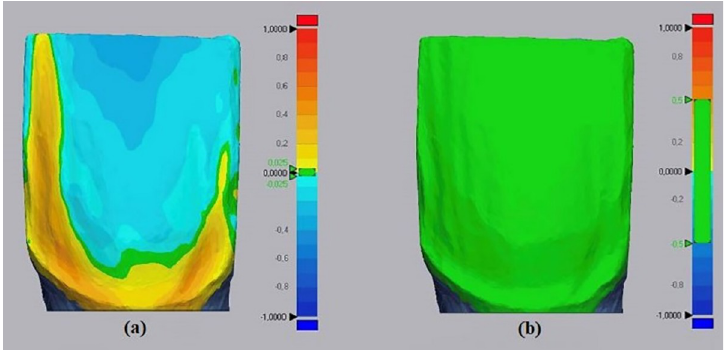
Fig 2. Comparison of tolerance for overlapping digital models in T1 and T2. (a) representative image showing the areas where resin residues are present in yellow, areas of dental wear in blue, and areas where there was no additional dental wear or presence of resin residues in green, with 0.025 mm of tolerance. (b) image showing a 0.5 mm of tolerance, being inadequate to obtain accurate results.